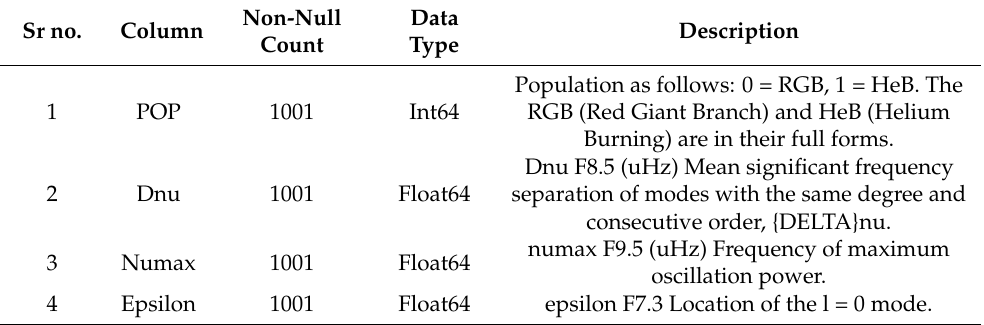
Table 2. The asteroseismology dataset features’ related information.